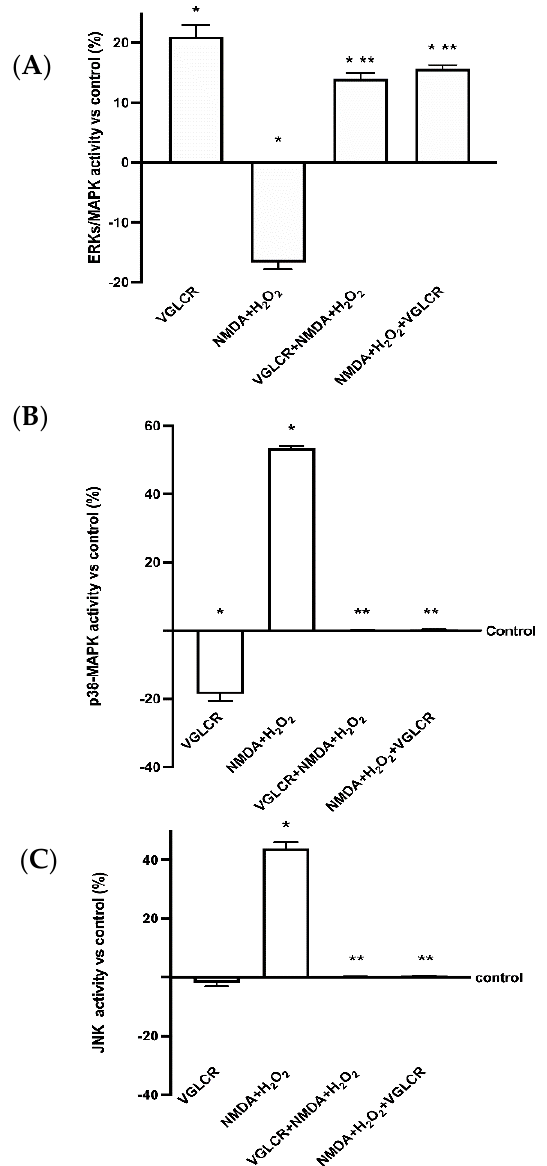
Figure 4. ELISA activity of ERKs ( A ), p38 ( B ), and JNK1/2 ( C ). All these markers were measured with NMDA and H 2 O 2 added together, and before and after VGLCR stimulations. The results are expressed as means ± SD (%) vs. control (0% line) of 4 independent experiments, each performed in triplicate. * p < 0.05 vs. control; ** p < 0.05 vs. NMA + H 2 O 2 . The abbreviations are the same as used in Figure